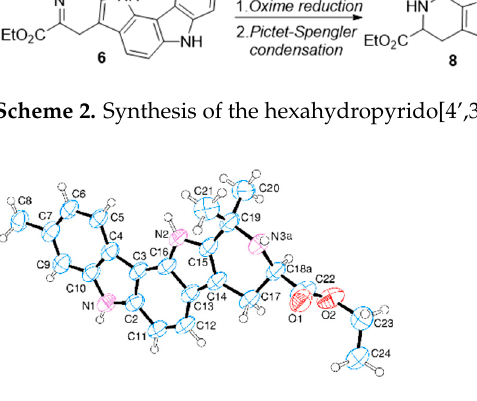
Figure 1. Crystal structure of 8 Figure 32. Crystal structure of 8 . Figure 32. Crystal structure of 8 . Figure 32. Crystal structure of 8 .